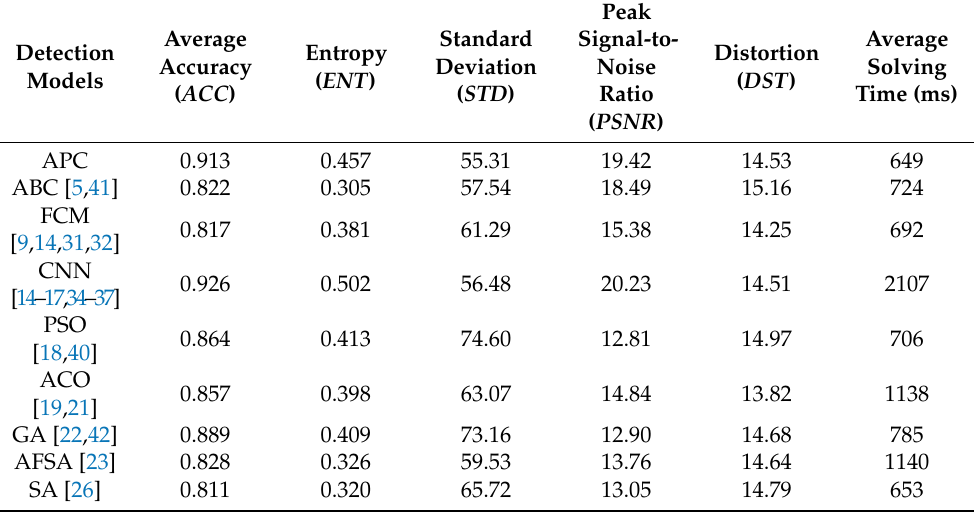
Table 5. Comparison of results of different models on Stanford background